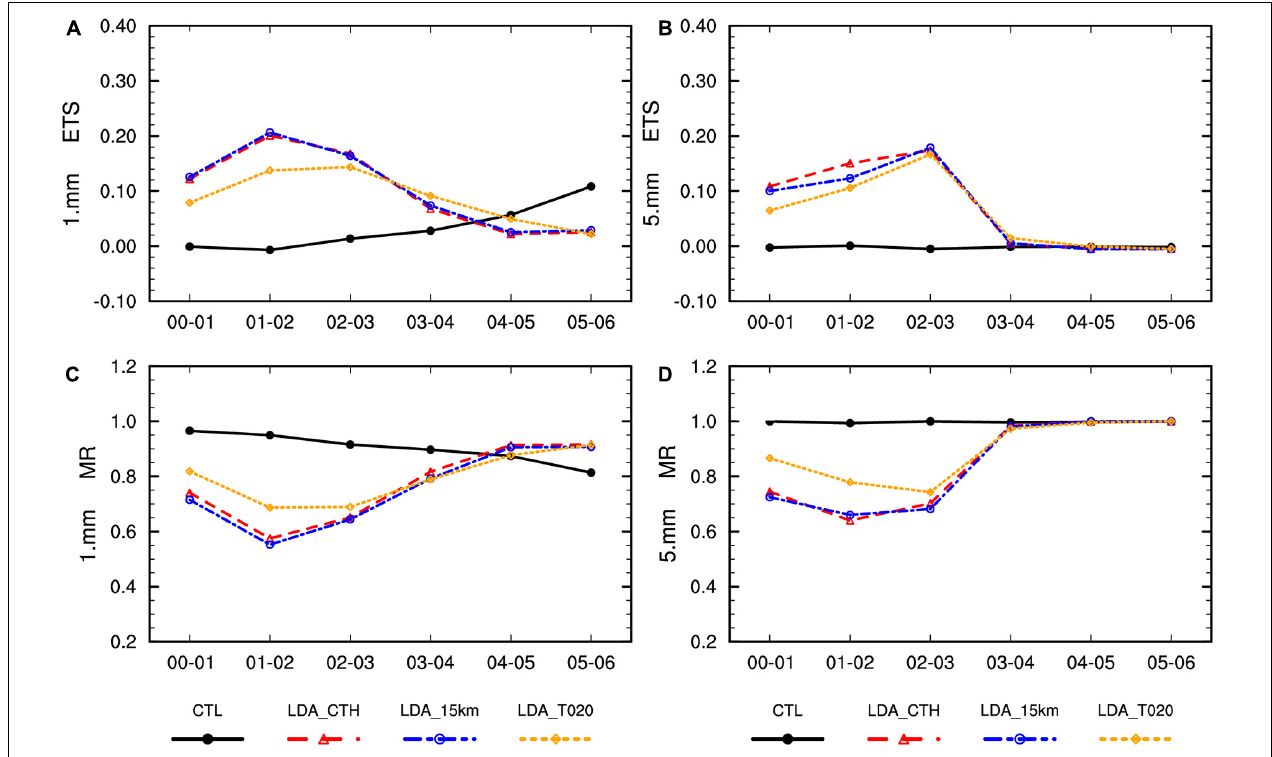
FIGURE 14 | As in Figure 12 , but for case 2 from 0900 UTC to 1500 UTC on 12 June 2018 for each experiment. (A) ETS for 1 mm, (B) ETS for 5 mm, (C) MR for 1 mm, (D) MR for 5